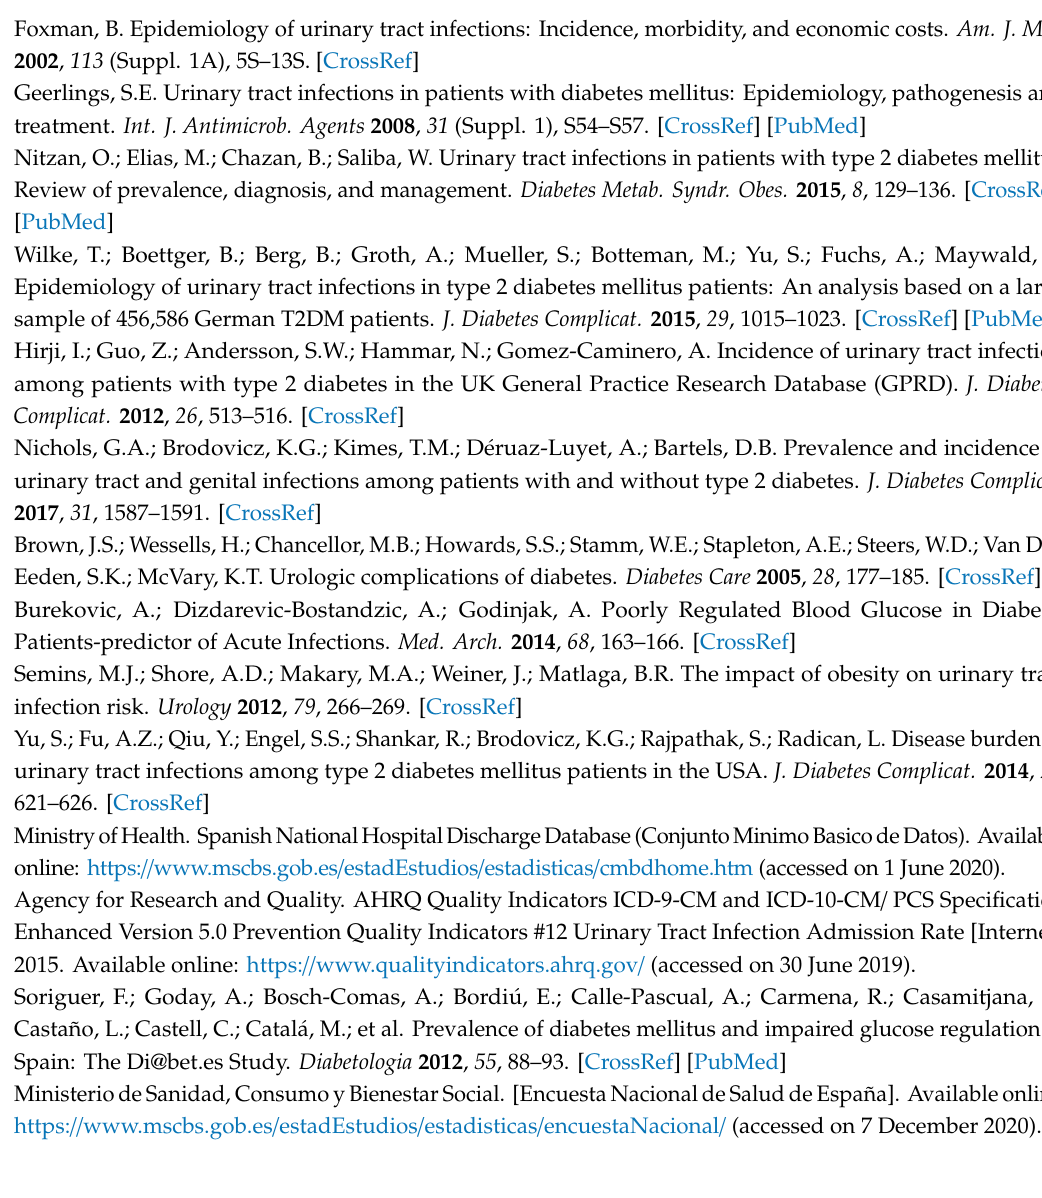
Table S1: ICD-9-CM and ICD-10 codes for the clinical diagnosis and procedures used in this investigation and Table S2: Variables associated with in-hospital mortality in hospital admissions of patients with a principal diagnosis of urinary tract infection according to sex in Spain